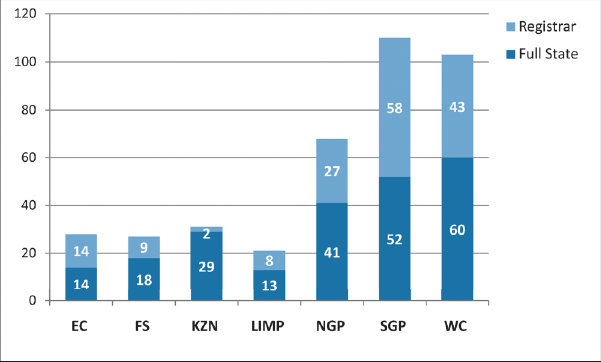
Fig. 3. Total number of psychiatric registrars registered as potential SASOP members per region. EC = Eastern Cape; FS = Free State; KZN = KwaZulu-Natal; LIMP = Limpopo; NGP = Northern Gauteng; SGP = Southern Gauteng; WC = Western